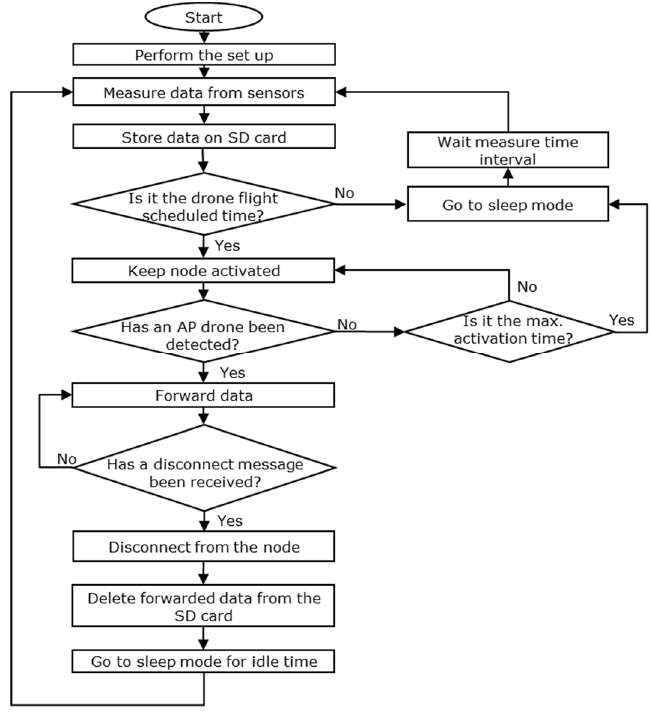
Figure 7. Algorithm of the node.